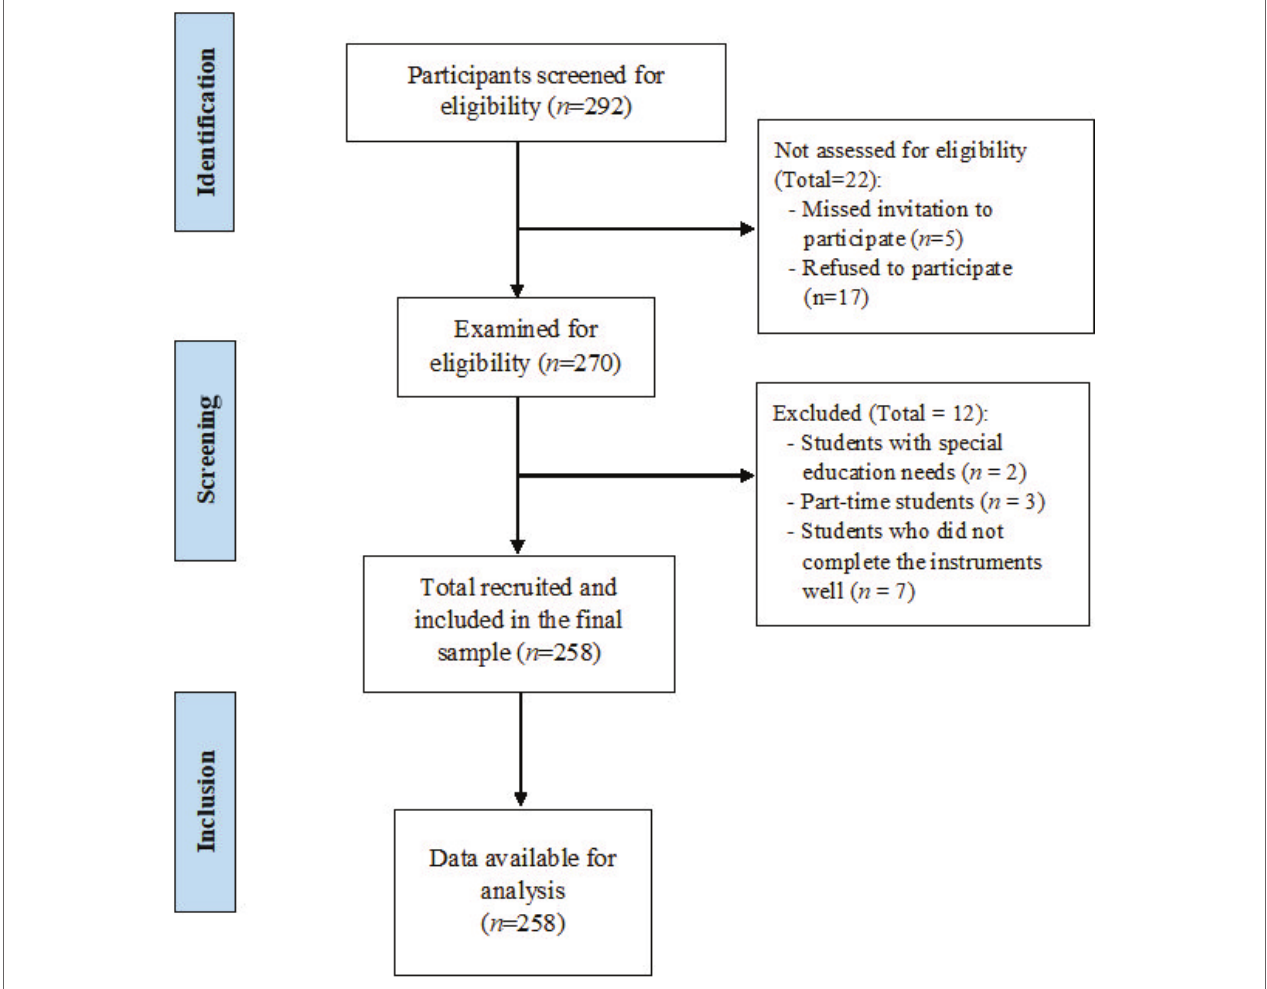
FIGURE 1 | Flow diagram of subjects who participated in the study according STROBE